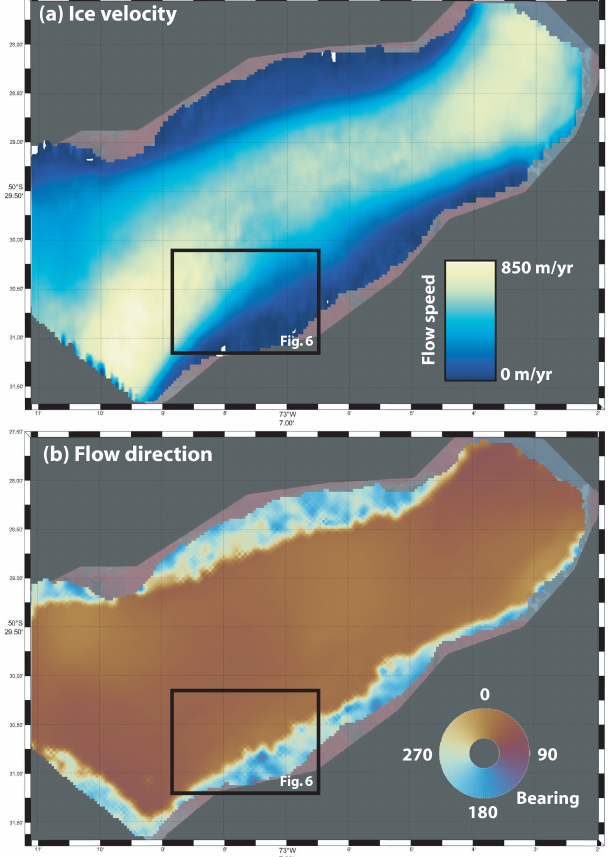
Figure 5. Mean flow velocity (myr − 1 ) (a) and direction (de- grees) (b) of Glaciar Perito Moreno, Argentina, for the first 3 months of 2020. Figure panels have been automatically generated from GIV, labels have been added, and the colour bars